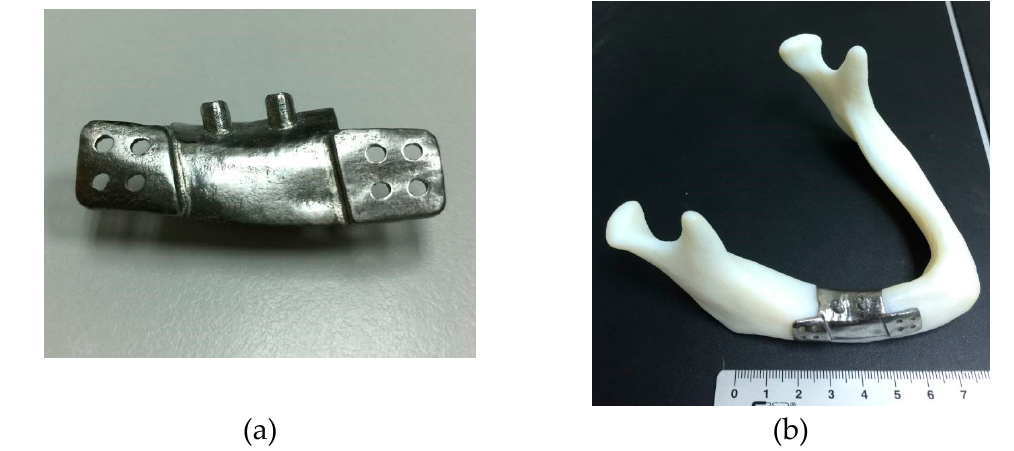
Figure 8. ( a ) A 3D-printed Ti-alloy reconstruction sample was constructed by referring to CAD model of Model 1 (length: 20 mm; thickness: 0.8 mm) and ( b ) was well placed in the defect of the artificial mandible.